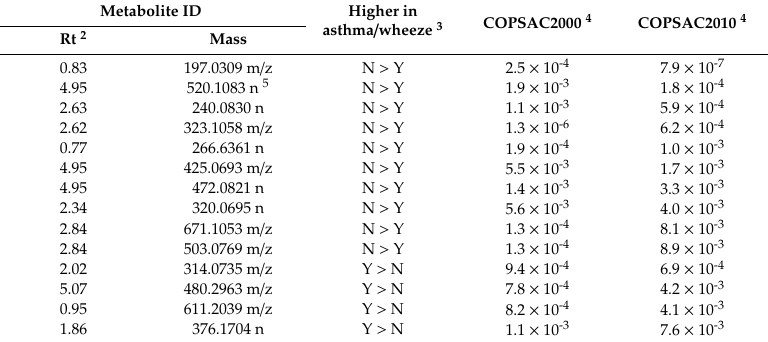
Table 3. Univariate data analysis results for variables selected in both COPSAC 1 cohorts.